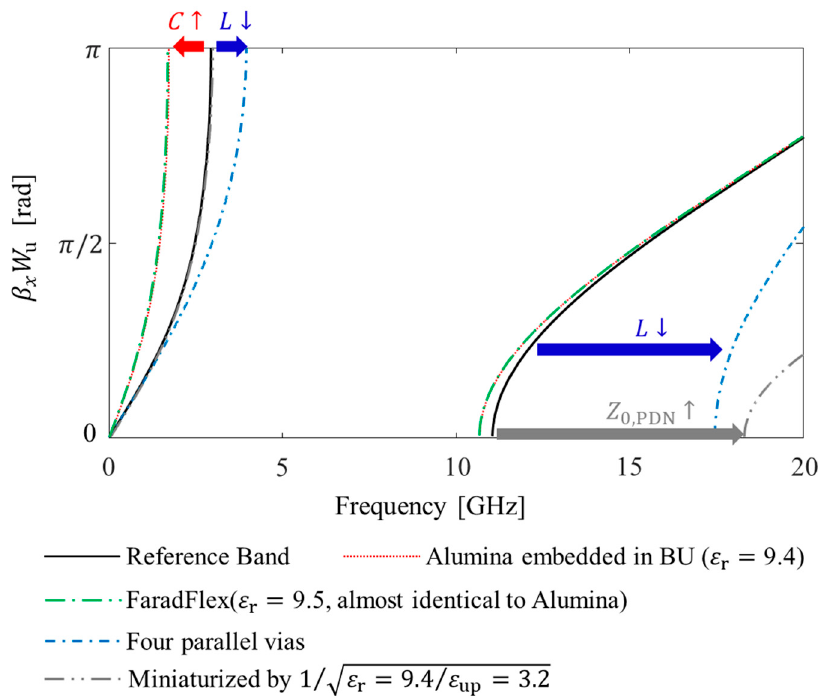
Figure 10. Dispersion diagrams for comparison. The impact of each parameter on stopband edge is also marked.